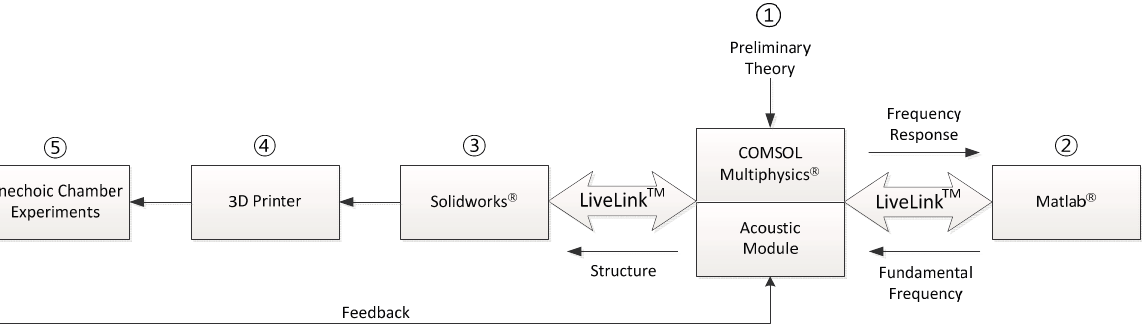
Figure 3. Workflow of NFML system